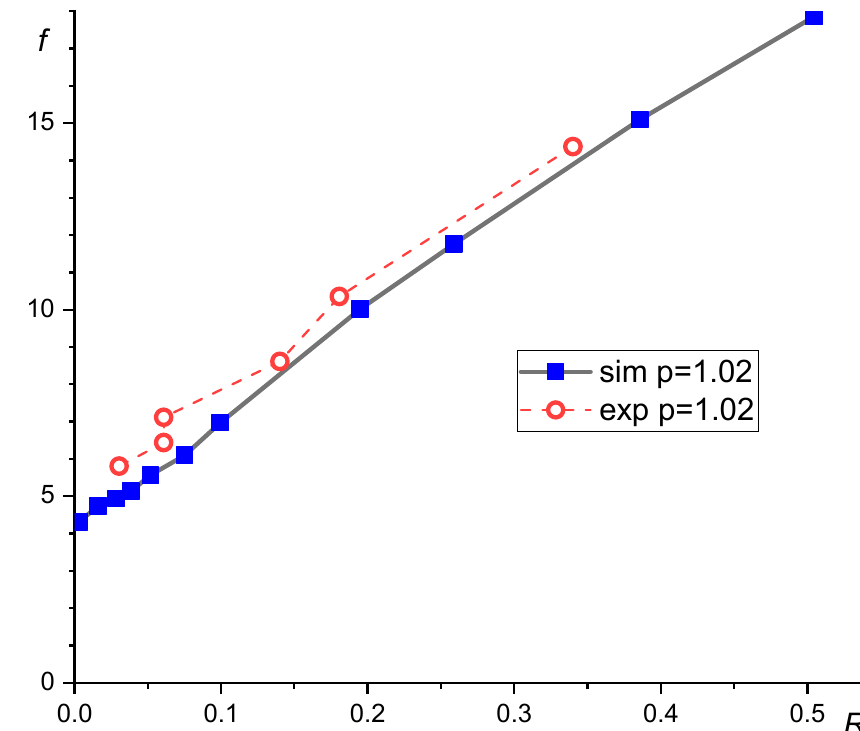
. γ t B ( R ∗ − 1) 1 / 2 on reduced droplet radius R ∗ found by